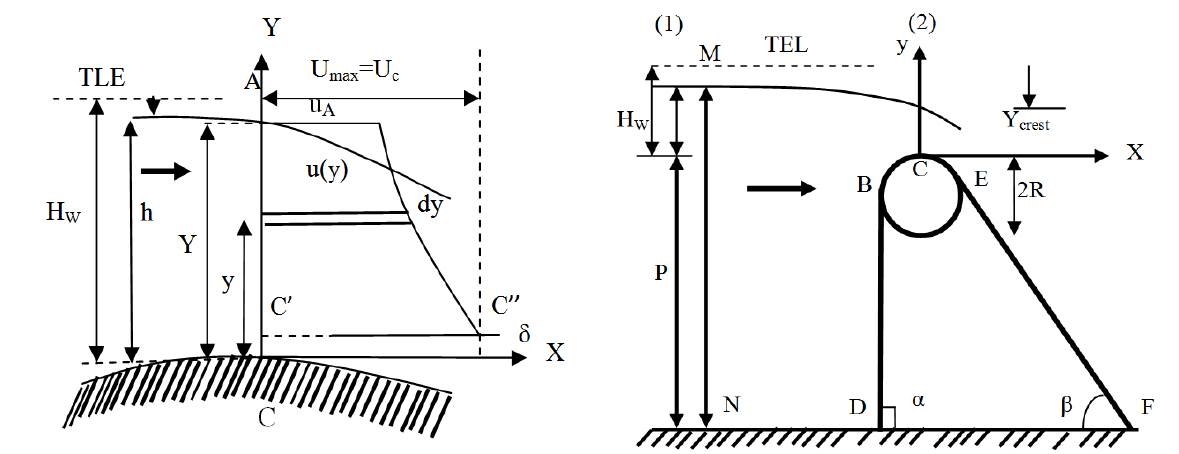
Fig. 1. Flow over the weir, velocity distribution, and boundary layer on the crest of a circular weir.